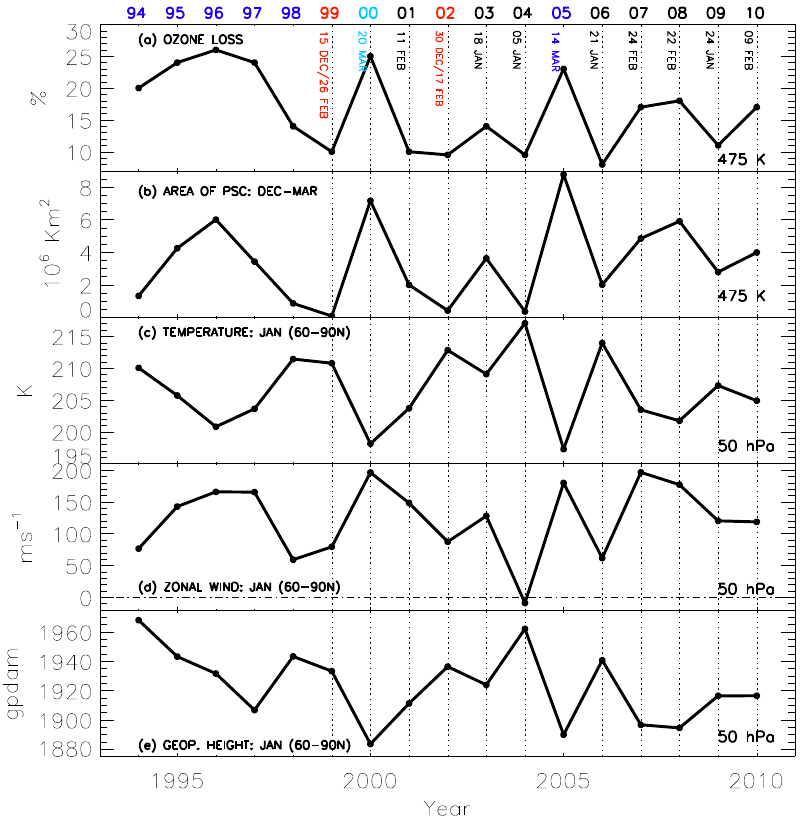
Fig. 7. (a) The cumulative total column ozone loss at the end of each winter (late March or early April and 20 February for 2009/10), (b) the average area of PSCs in December–March at 475K, (c) the zonal-mean temperatures, (d) zonal winds, and (e) geopotential heights averaged over 60–90 ◦ N in January at 50 hPa for the Arctic winters 1993/94–2009/10. The UV-visible ozone loss estimate for each year is taken from Goutail et al. (2005), WMO (2007), and Kuttippurath et al. (2010). The winters with MW are marked with dotted vertical lines and the zero-wind line is marked with a dash-dotted line. The central date for each MW is also noted on the top panel (a) . The winters 1998/99 and 2001/02 had 2MWs and the MW in 1999/00 was in late March.